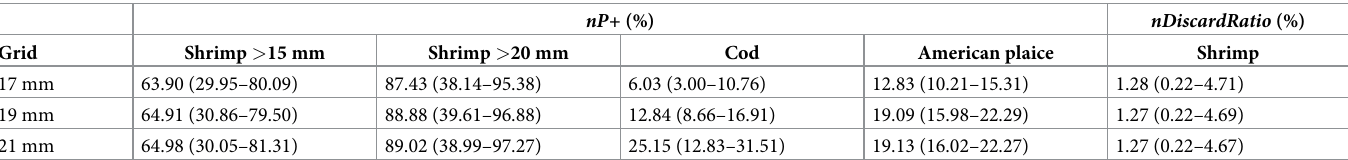
Table 5. Catch efficiency indicators nP+ (in %) for Northern shrimp with carapace lengths > 15 mm and > 20 mm, respectively, and bycatch species (cod and Amer- ican plaice) and fraction of undersized shrimp ( nDiscardRatio ) (in %) when using the 17, 19 and 21 mm bar spacing grids combined with the 35 mm codend for the population